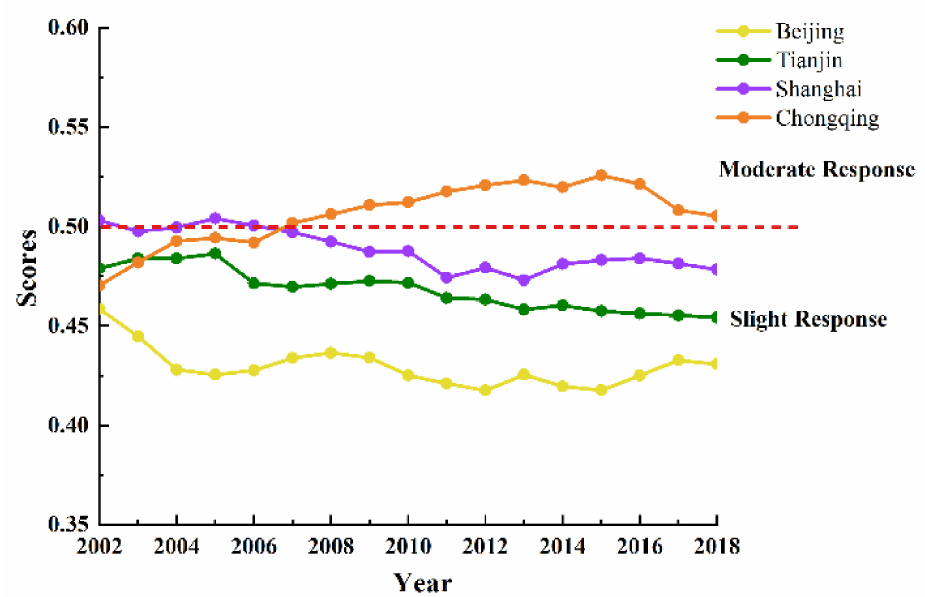
Figure 5. Trends in response resilience from 2002 to